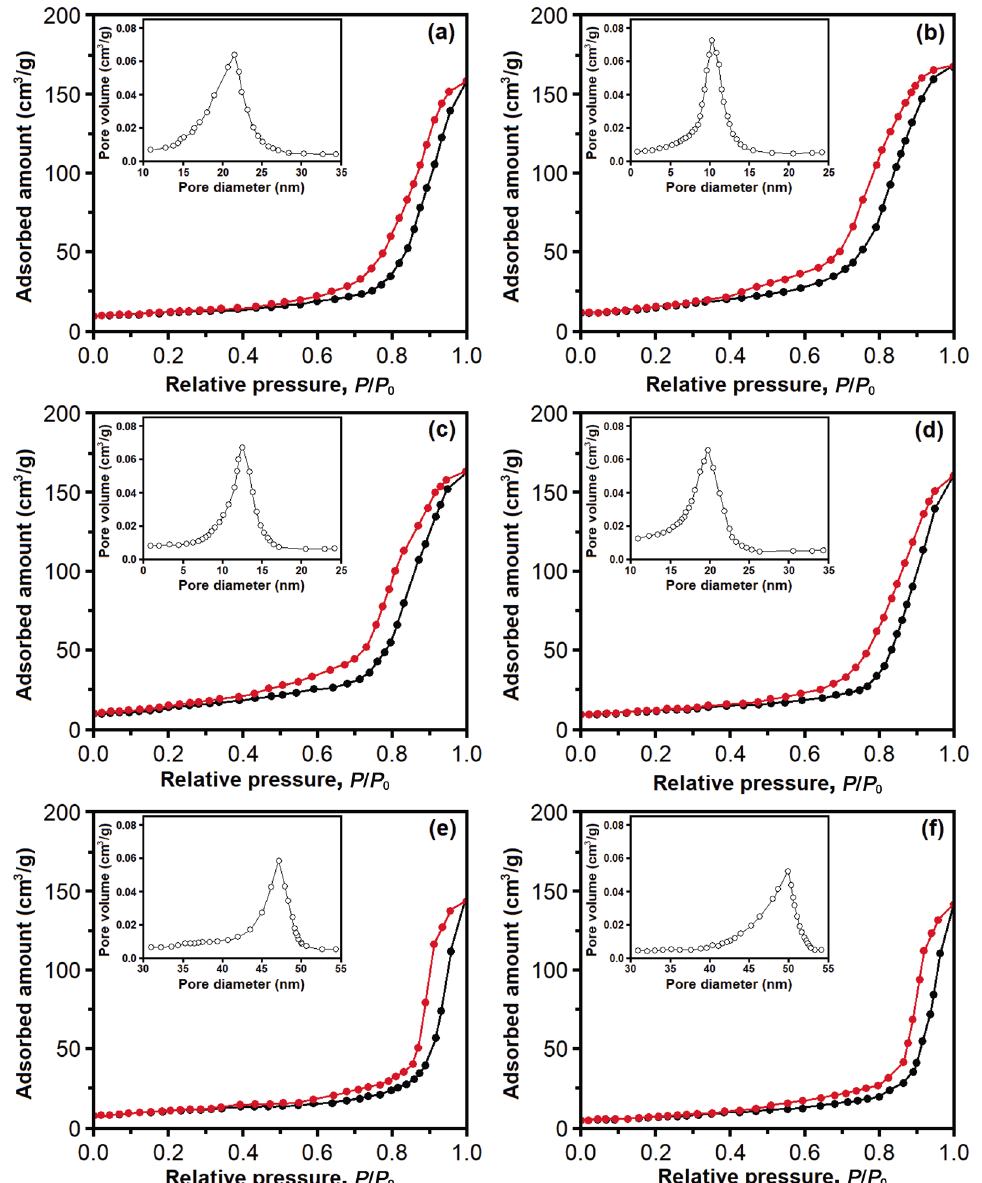
Fig. 5 N 2 adsorption/desorption isotherms and the corresponding Barrett–Joyner–Halenda (BJH) pore size distribution plots (insets) for (a) the undoped TiO 2 nanorod, and N–Fe codoped TiO 2 nanorods annealed at (b) 400 ℃ , (c) 500 ℃ , (d) 600 ℃ , (e) 700 ℃ , and (f) 800 ℃